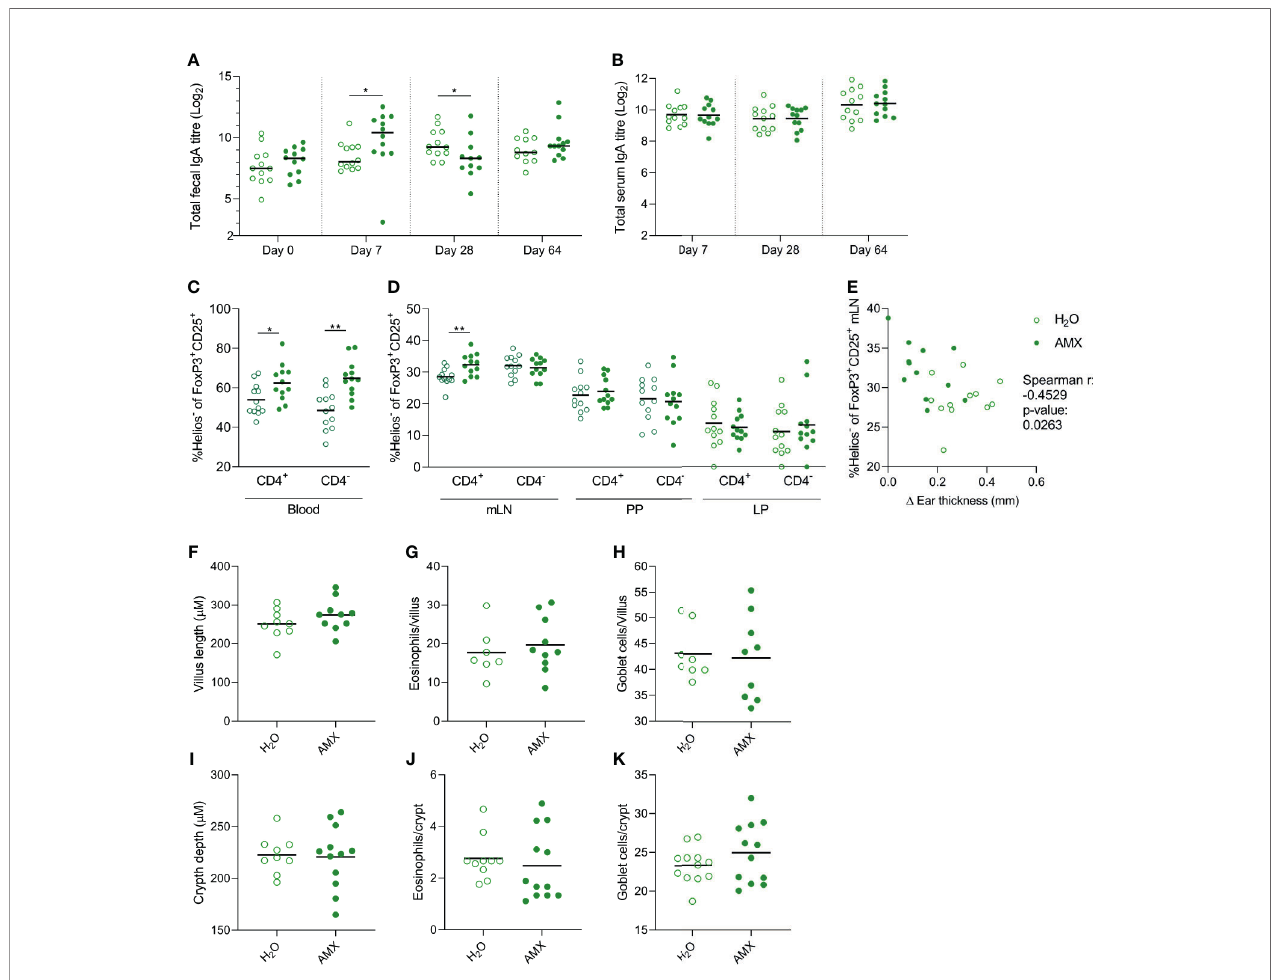
FIGURE 7 | Effect of amoxicillin administration on immune regulation in the extensively hydrolysed whey (eHW) group. Total faecal (A) and total serum (B) IgA titres in conventional (H 2 O, open symbols) and amoxicillin (AMX, closed symbols) groups. Fraction of Helios - Tregs out of the CD25 + FoxP3 + Treg populations (both CD4 + and CD4 - ) in blood (C) , and mesenteric lymph nodes (mLN), Peyer ’ s patches (PP) and lamina propria (LP) (D) . Correlation between fraction of Helios - Tregs out of the CD4 + Treg populations and ear swelling after intradermal injection of intact whey (E) . Average villus length (F) , eosinophil (G) and goblet cell (H) count per villus in small intestine, and average crypt depth (I) , eosinophil (J) and goblet cell (K) count per crypt in colon. Each symbol represents one rat and horizontal lines indicate median (A) or mean (B – K) values. Statistically signi fi cant differences between groups are indicated as *p ≤ 0.05, **p ≤